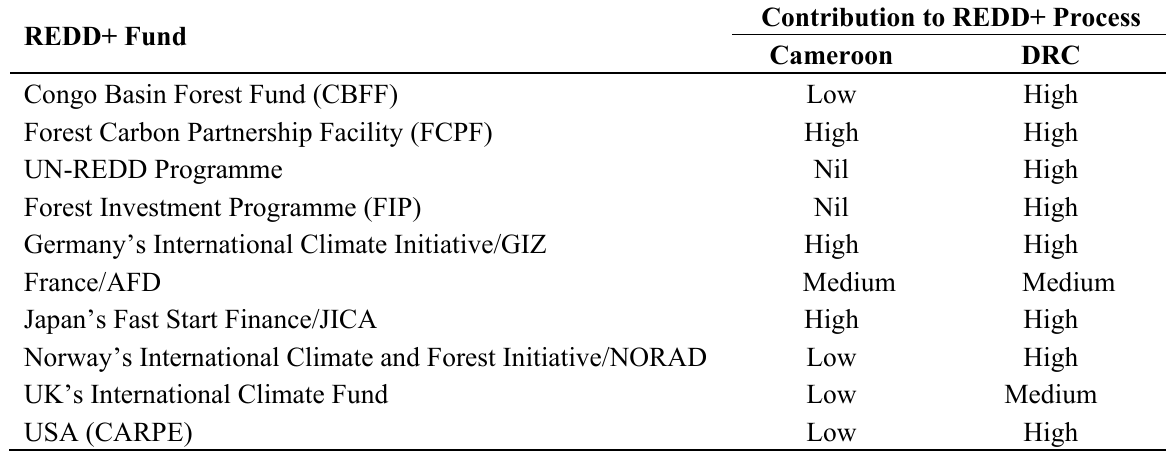
Table 5. Key multilateral and bilateral REDD+ donors in Cameroon and